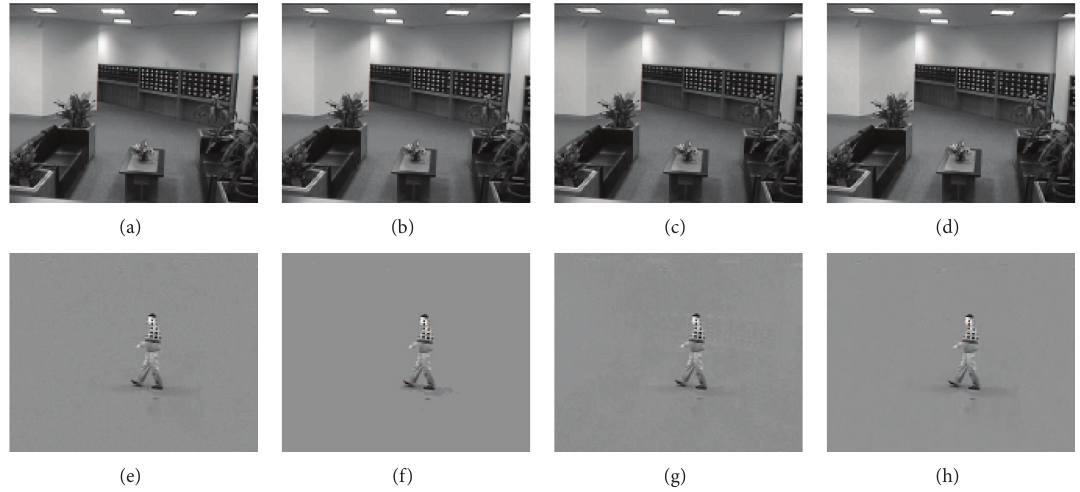
Figure 2: Lobby: (a)–(d) background and (e)–(h) foreground from IALM, GoDec, NSMP, and